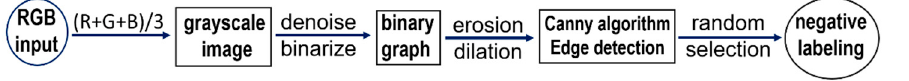
Figure 3. Summary of the traditional image preprocessing procedure used to select and label some of the cells in the negative image samples.